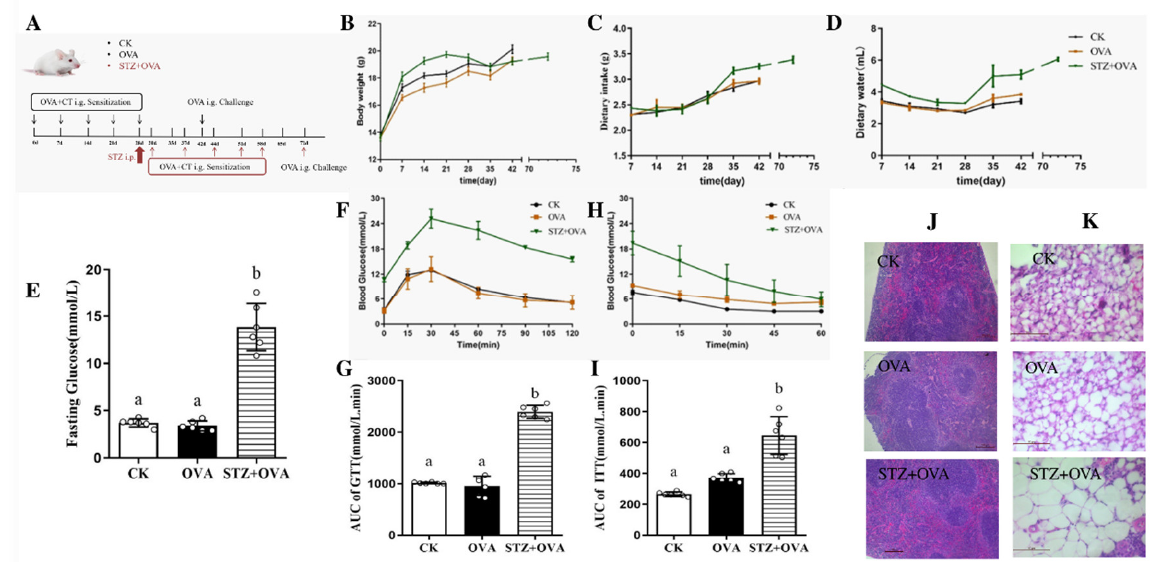
Figure 1. Establishment of diabetic allergy (STZ + OVA) mice model. ( A ), schematic figure of the effect of diabetes on food allergy: mice were divided into CK, OVA, and STZ + OVA group mice. OVA group mice were given OVA and CT on day 0, 7, 14, 21, 28, and 42. The STZ+ OVA group mice were given STZ on day 28. On day 30, 37, 44, 51, 58, and 72, mice were given OVA and CT. i.g., intragastric. ( B ), Body weight. ( C ), Dietary intake. ( D ), Dietary water. ( E ), Fasting glucose. ( F ), Glucose tolerance. ( G ), Area under curve (AUC) of glucose tolerance. ( H ), Insulin tolerance. ( I ), AUC of insulin tolerance. ( J ), H&E staining of spleen (scale bar = 100 µ m). ( K ), H&E staining of visceral adipose tissue (scale bar = 50 µ m). The error bars indicated the mean ± SEM. n = 6. Different lowercase letters in the figure represent significant differences between the groups ( p < 0.05 by one-way ANOVA followed by